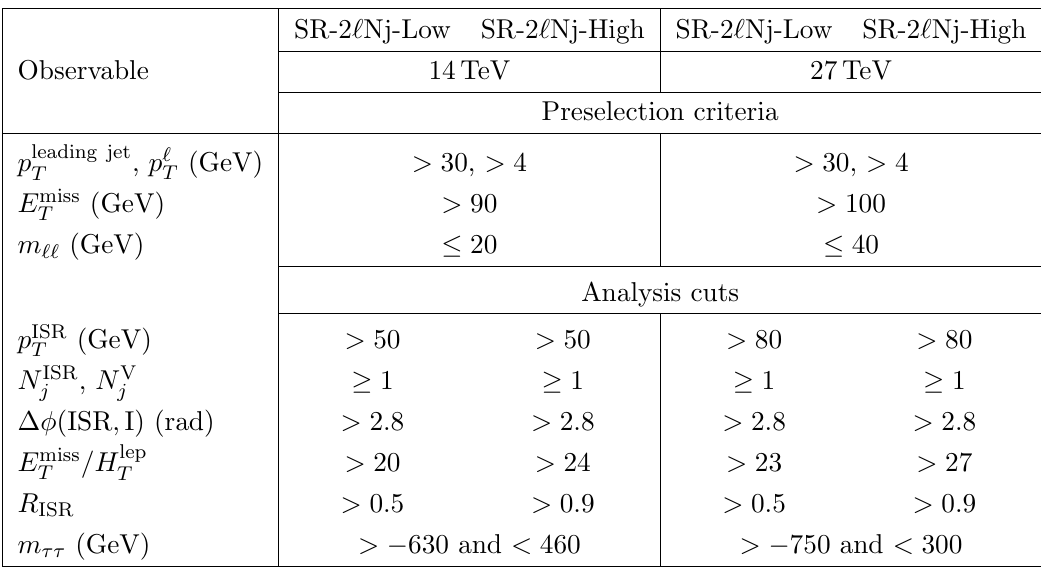
Table 6. Preselection and analysis cuts (at 14 TeV and 27 TeV) applied to the signal and SM backgrounds for two signal regions targeting low and high electroweakino mass